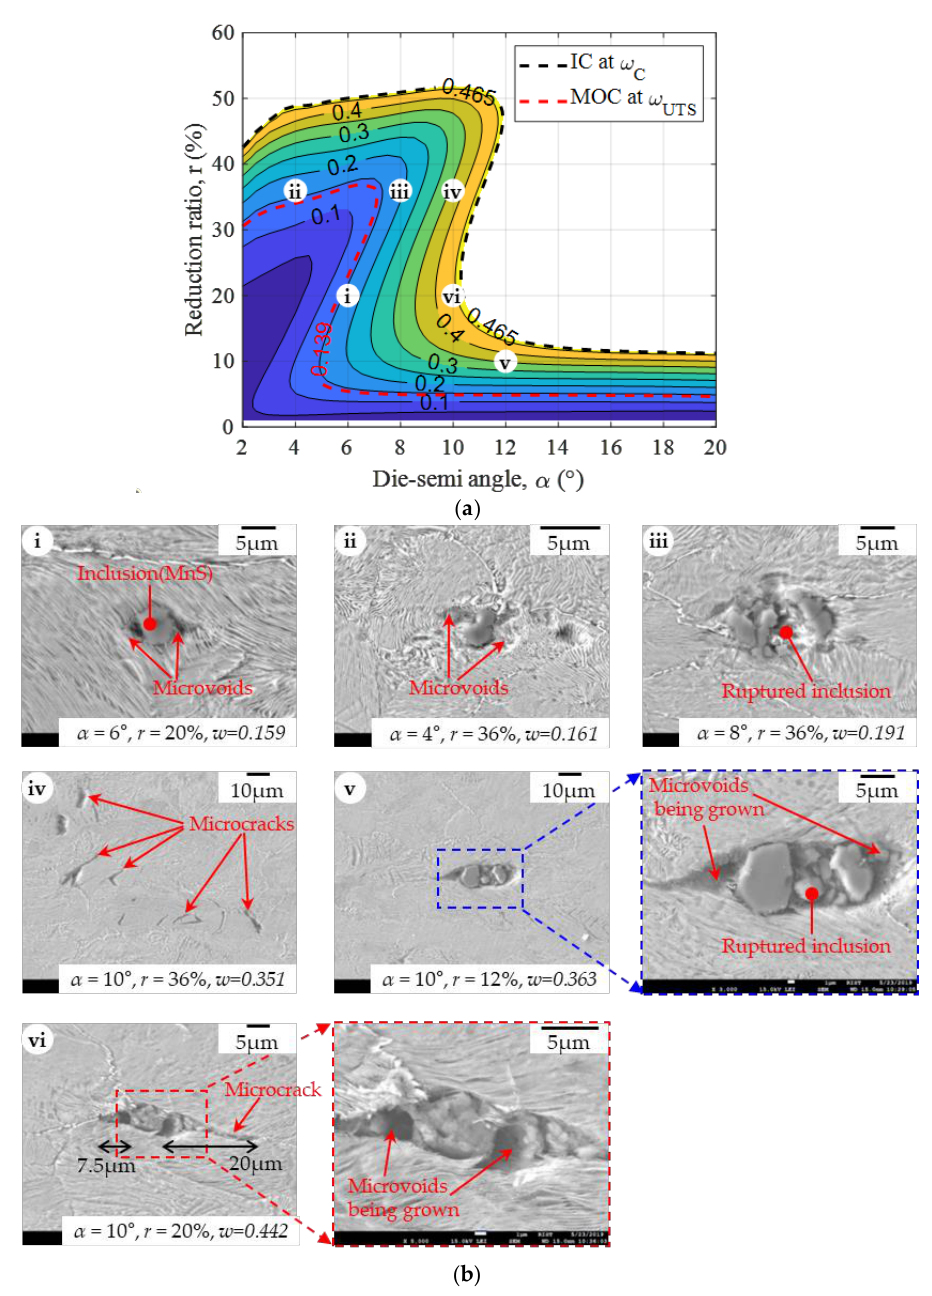
Figure 7. ( a ) PCD of SUJ2Z. ( b ) Scanning electron microscopy (SEM) micrographs for various α and r combinations: (i) α = 6°, r = 20%, and ω = 0.159; (ii) α = 4°, r = 36%, and ω = 0.161; (iii) α = 8°, r = 36%, and ω = 0.191; (iv) α = 10°, r = 36%, and ω = 0.351; (v) α = 10°, r = 12%, and ω = 0.363; and (vi) α = 10°, r = 20%, and ω = 0.442.